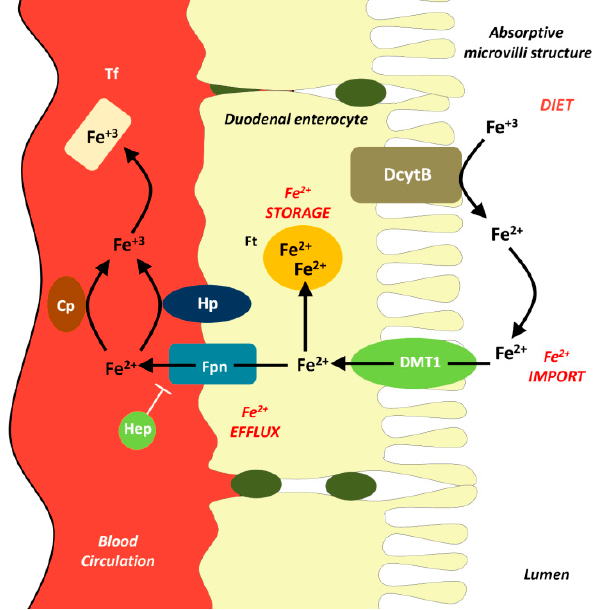
Figure 1. Dietary iron absorption and transport across duodenal enterocytes. Dietary ferric iron (Fe 3+ ) is converted to ferrous iron (Fe 2+ ) by the apical ferric reduc- tase duodenal cytochrome b (DcytB). After Fe reduction to the ferrous form (Fe 2+ ), it could cross into the cytoplasm by an apical Fe transporting divalent metal transporter-1 (DMT1, also known as DCT1, SLC11a2, and Nramp2). Both DcytB and DMT1 are localized to the microvilli-covered surface of simple columnar and simple cuboidal epithelium, known as the brush border. Iron is either stored or moved from the enterocyte into the circulation through the sole basolateral transporter ferroportin (Fpn, also named SLC40A1). The fer- roxidase hephaestin (Hp), aided by ceruloplasmin (Cp), oxidizes Fe 2+ to Fe 3+ to enable loading onto the plasma carrier protein transferrin (Tf). Hepcidin (Hep) decreases serum iron levels by inhibiting iron release by